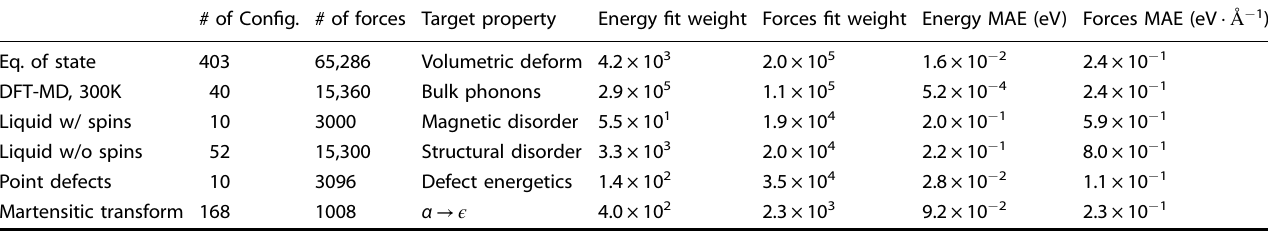
Table 1. Training set for linear SNAP model.